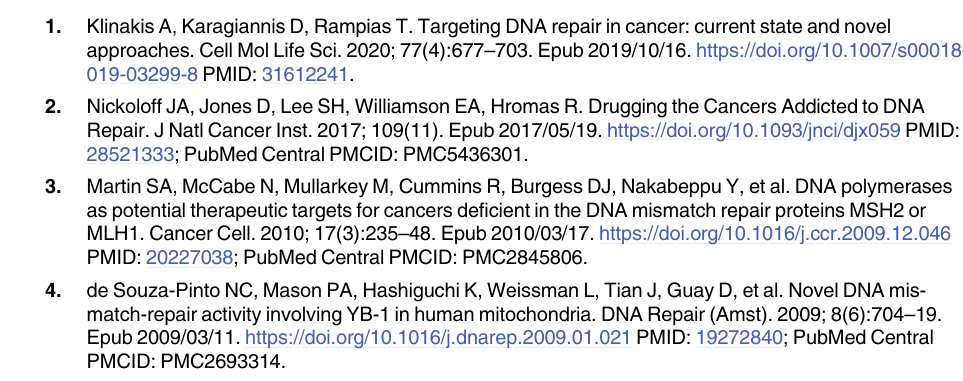
bars represent the standard deviation of the mean. The Grey arrow indicates the time of the compound administration. S6 Fig. Generation of Pol γ knockout HCT116 cell lines by CRISPR/Cas9. A. Western blot analysis with HCT116 single cell clones (Lane 1. Parental HCT116, lane 2. HCT116-CRISPR#1 clone #12, lane 3. HCT116-CRISPR#6 clone #27, lane 4. HCT116-CRISPR#6 clone #43, lane 5. HCT116-CRISPR#6 clone #44. M, Molecular marker-Precision plus protein dual color stan- dards from Bio-Rad. B. Sanger sequencing results of HCT116 clones. The translation start codon is shown in bold, the HpyCH4III restriction site is shown in italics, and the CRISPR/ Cas9 sgRNA target site is underlined. The dashed lines indicates deletions. S7 Fig. CR decreases mtDNA copy number in MLH1 deficient cells. � p = 0.0004; �� p = 0.0001; ��� p < 0.0001; ns, not